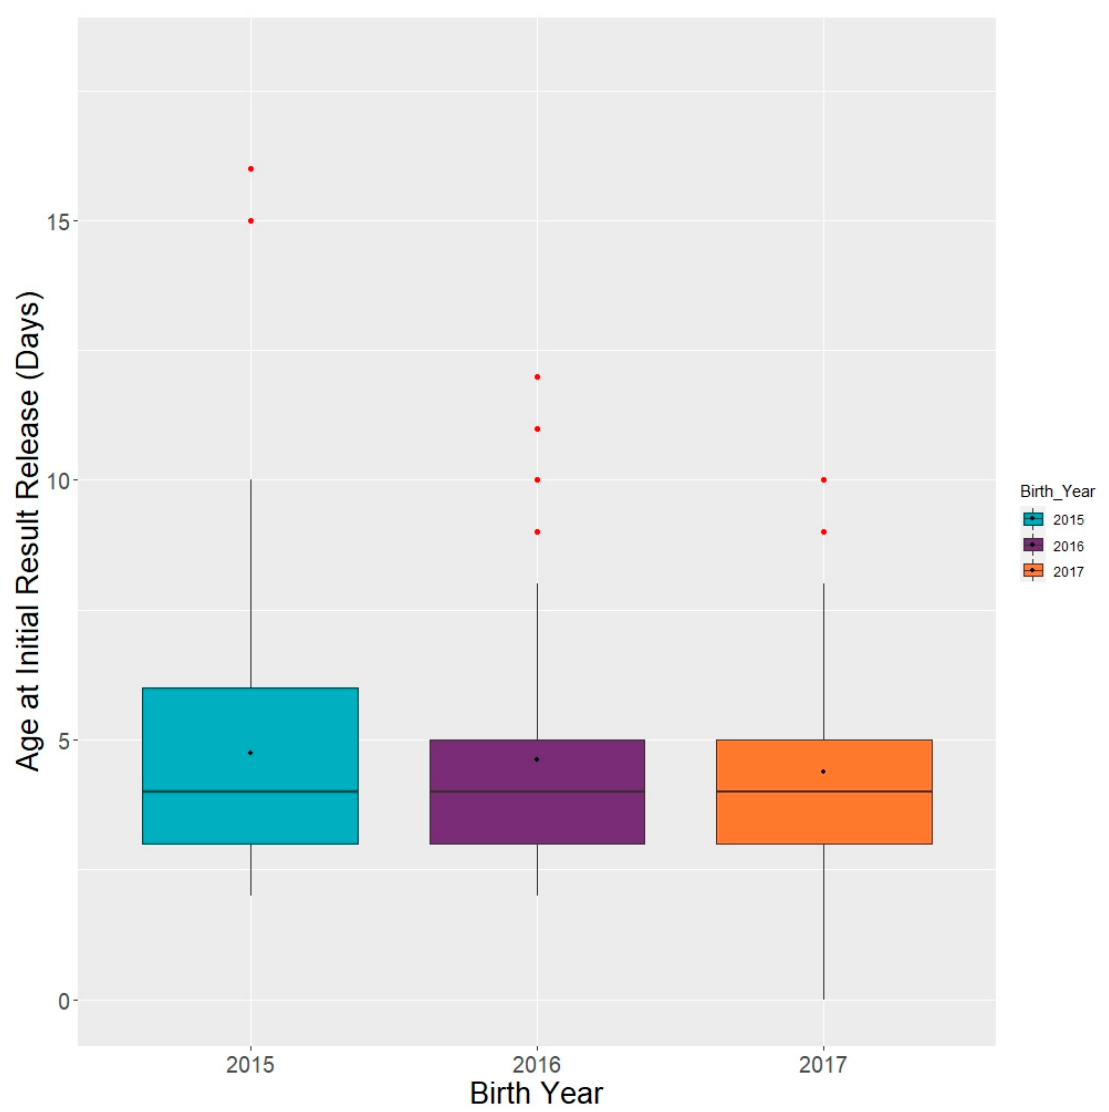
Figure 8. Congenital adrenal hyperplasia cases: time interval from birth to release of out-of-range results ( N =